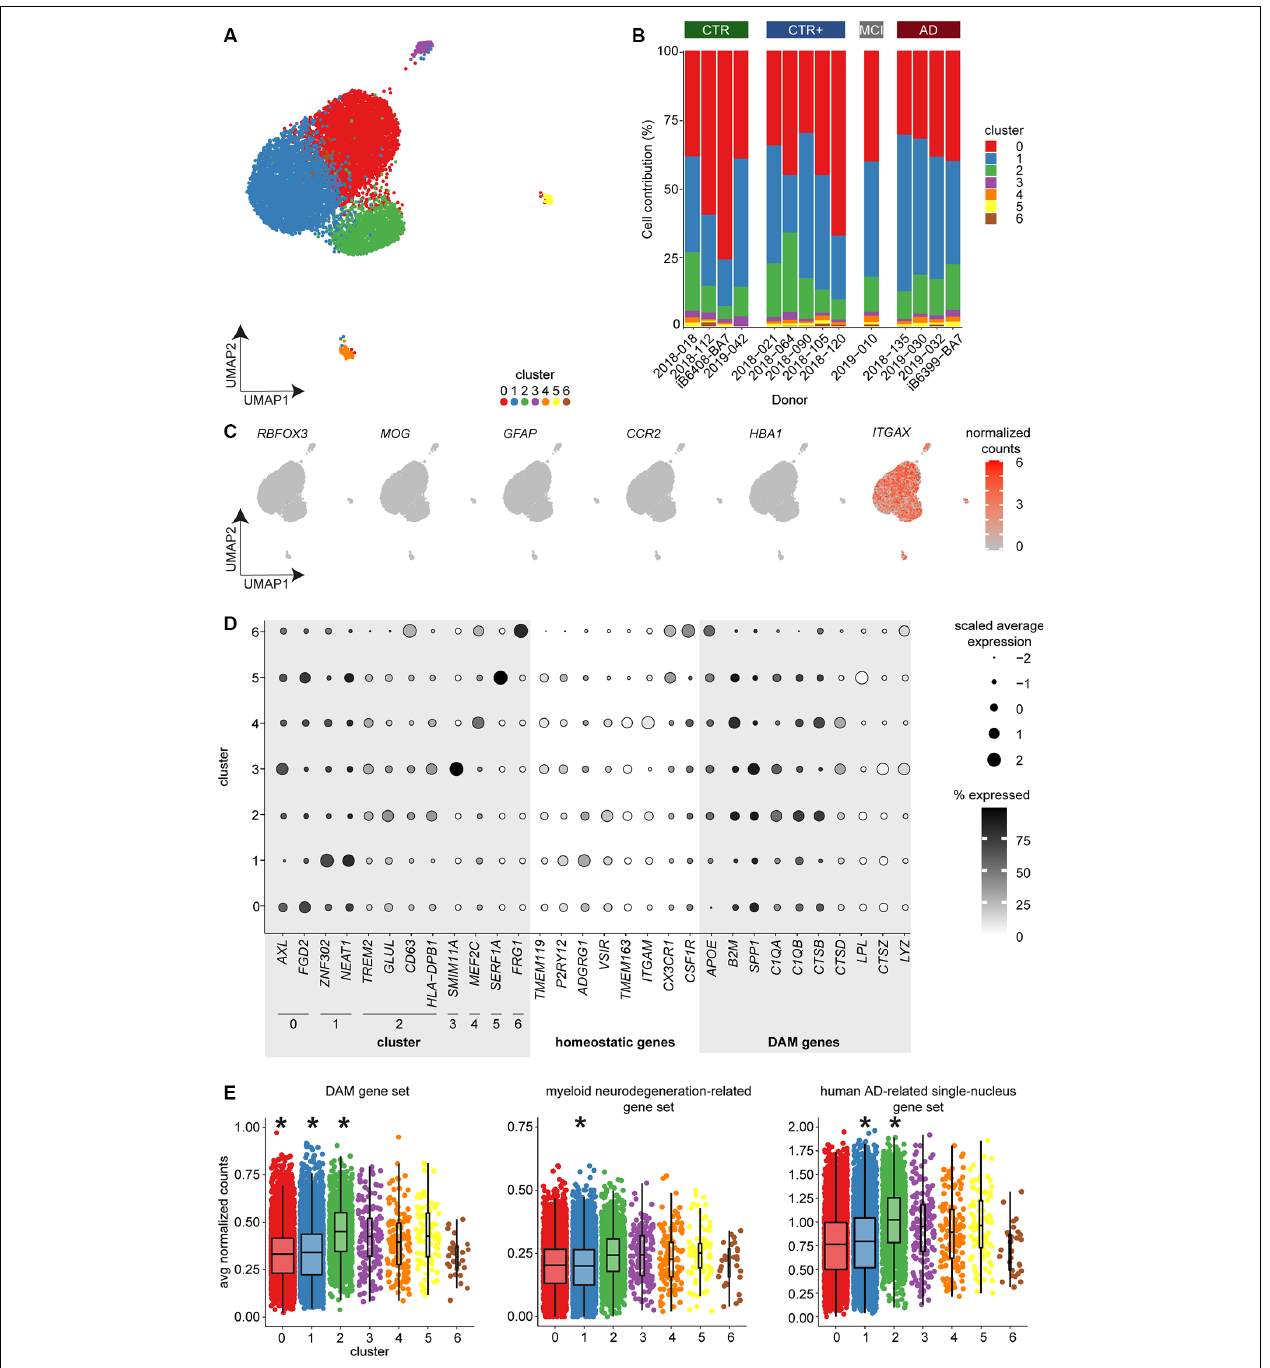
FIGURE 3 | Single-cell expression profiling of microglia identified seven subsets of microglia but no AD-associated cluster using bc-Smart-seq2. (A) UMAP visualization and unsupervised clustering of microglia derived from AD ( n = 4), MCI ( n = 1), CTR+ ( n = 5), and CTR ( n = 4) donors. Colors represent cluster identity. (B) Cluster contribution normalized to donor. (C) Expression of cell type–specific markers for neurons ( RBFOX3 ), oligodendrocytes ( MOG ), astrocytes ( GFAP ), circulating monocytes ( CCR2 ), erythrocytes ( HBA1 ), and microglia ( ITGAX ). (D) Dot plot visualizing scaled average expression and the percentage of cells expressing the indicated genes. (E) Average expression of the mouse DAM (Keren-Shaul et al., 2017), myeloid neurodegeneration-related (Friedman et al., 2018), and human AD-related single-nucleus (Mathys et al., 2019) gene sets per cell across clusters (multiple linear regression with Bonferroni correction, *indicate p -value < 0.001). Horizontal lines in the boxplots represent the mean; the lower and upper hinges represent the 25th and 75th percentiles. Abbreviations: AD, Alzheimer’s Disease; avg, average; CPM, counts per million; CTR, Control; CTR+, Control with A β plaques and/or hyperphosphorylated tau; DAM, disease-associated microglia; MCI, mild cognitive impairment; UMAP, uniform manifold approximation and